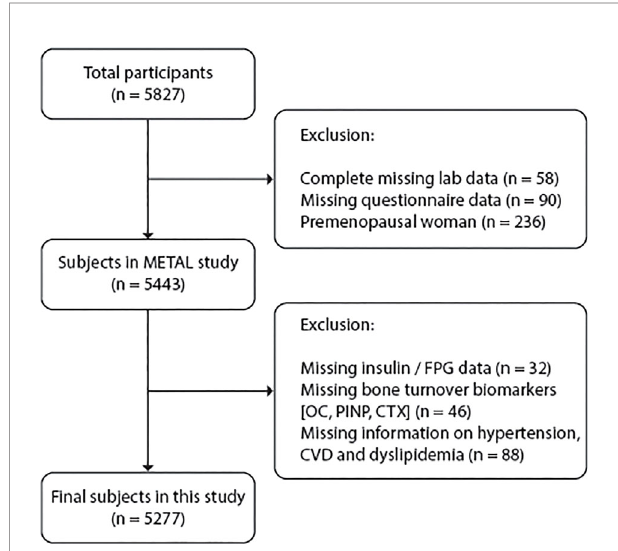
FIGURE 1 | Flow chart of study participant selection (inclusions and